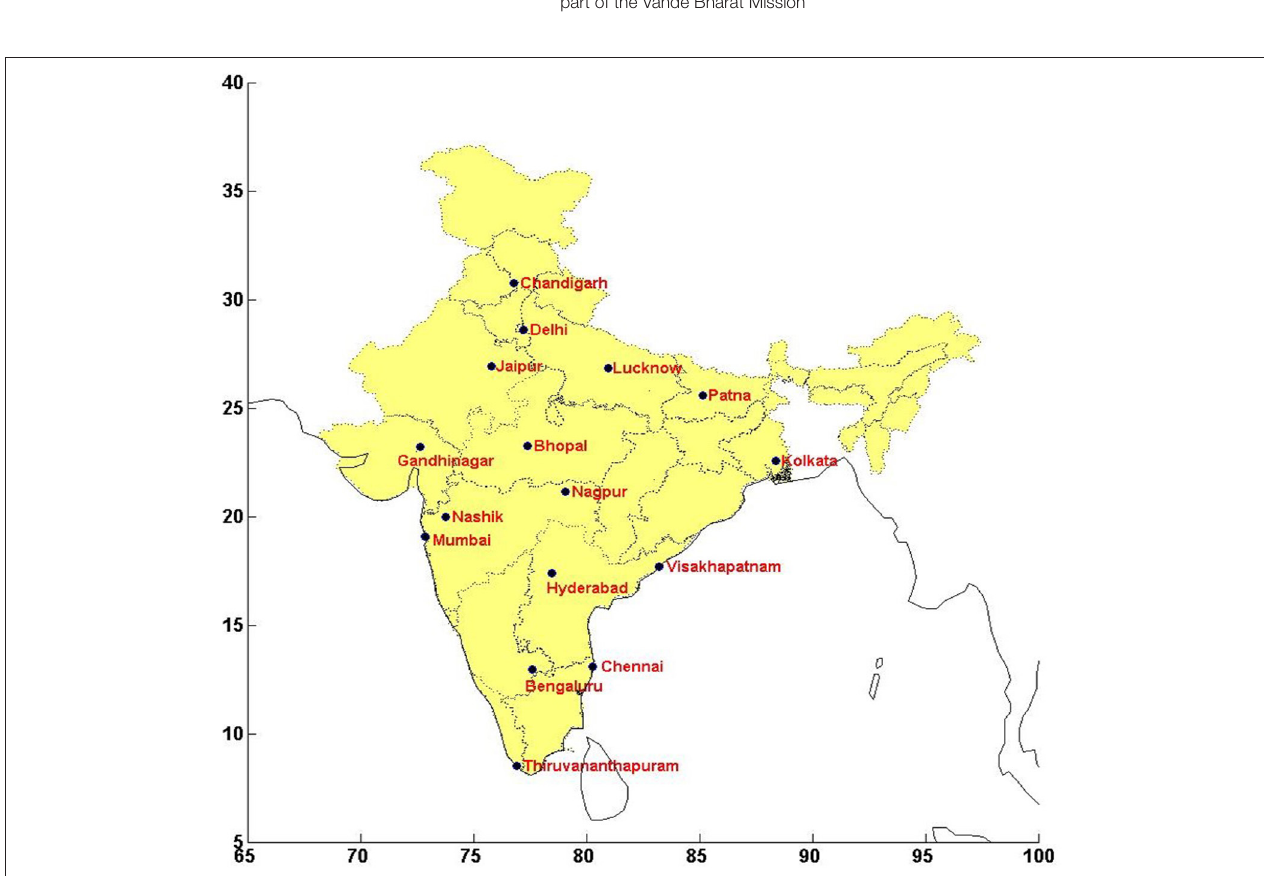
FIGURE 1 | Map of India showing the geographical location of all the 16 cities studied herein.